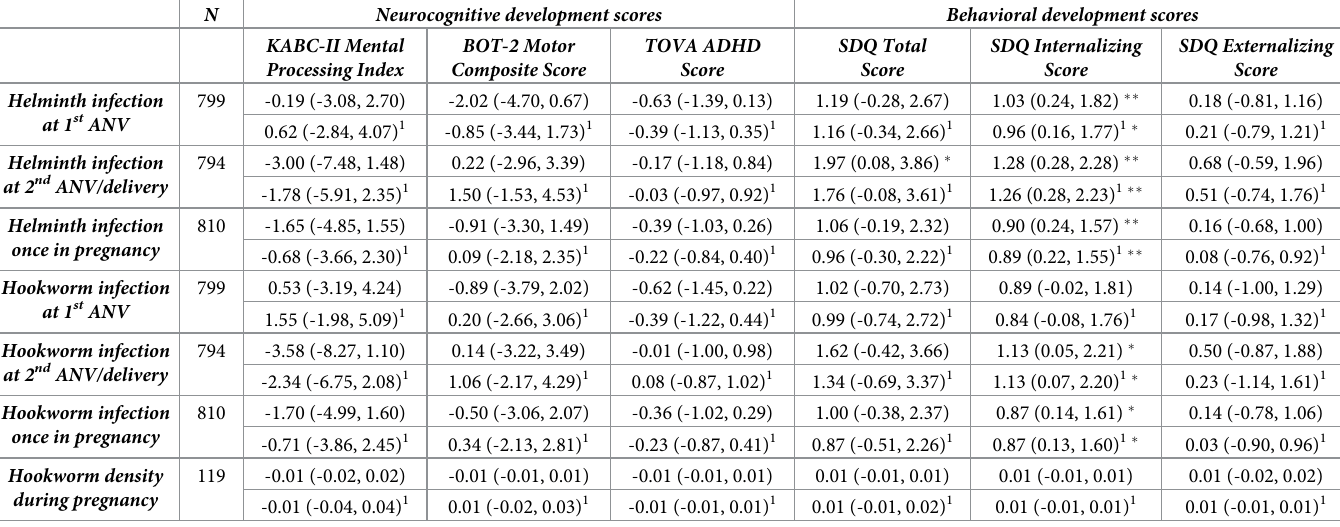
Table 5. Crude and adjusted coefficients (95% CI) from multiple linear regression models after imputation of missing variables and children lost to follow-up.